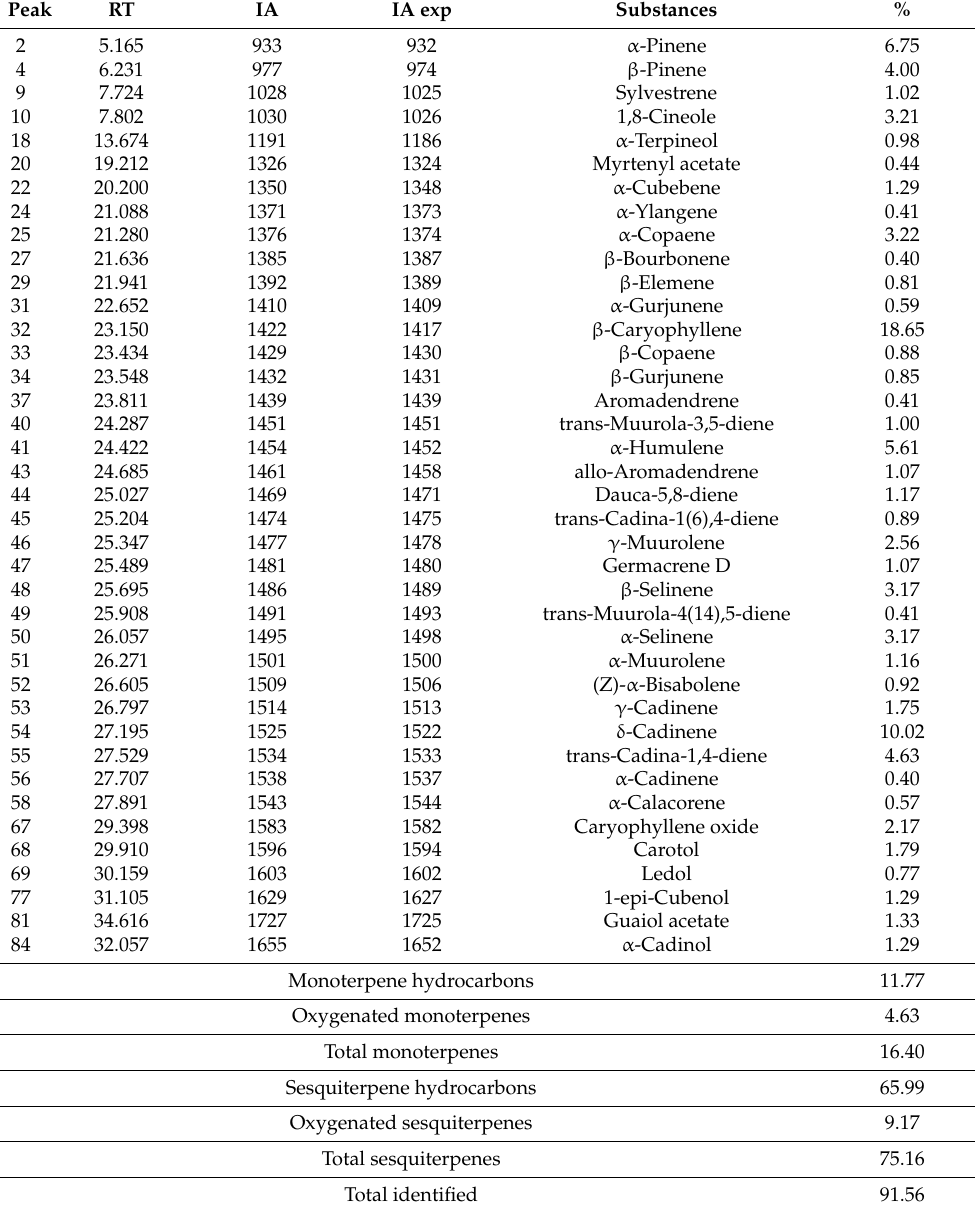
Table 1. Chemical composition of essential oil of Eugenia sulcata fresh leaves after search by GC-FID and